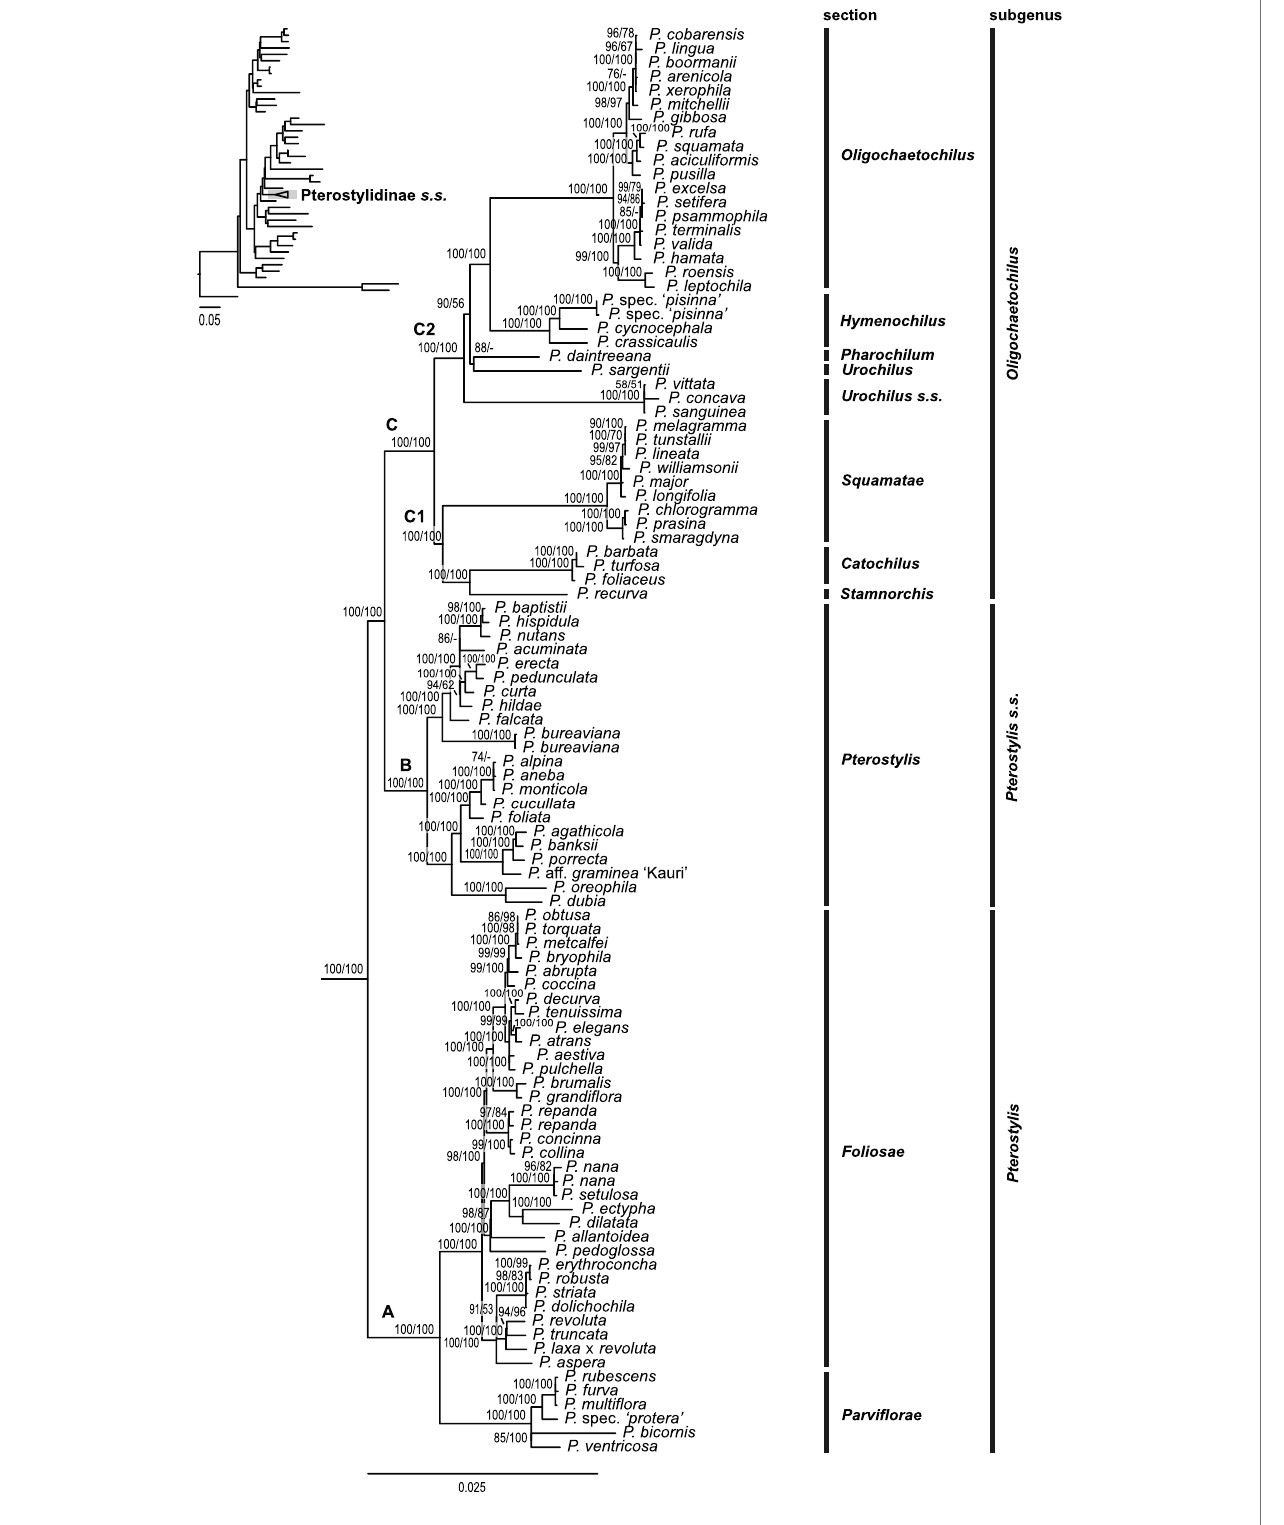
FIGURE 4 | Phylogenetic relationships within Pterostylis based on maximum likelihood analysis of 75 plastid genes (91,090 bp alignment) with IQ-TREE. Labels A, B and C refer to the three major clades within the genus, C1 and C2 represent the two main clades within clade C. Nodal support values >50 are given above branches (ultrafast bootstrap values from IQ-TREE analysis followed by bootstrap values from RAxML analysis). Tree insert shows phylogenetic position of Pterostylidinae in orchid phylogeny (see Figure 3